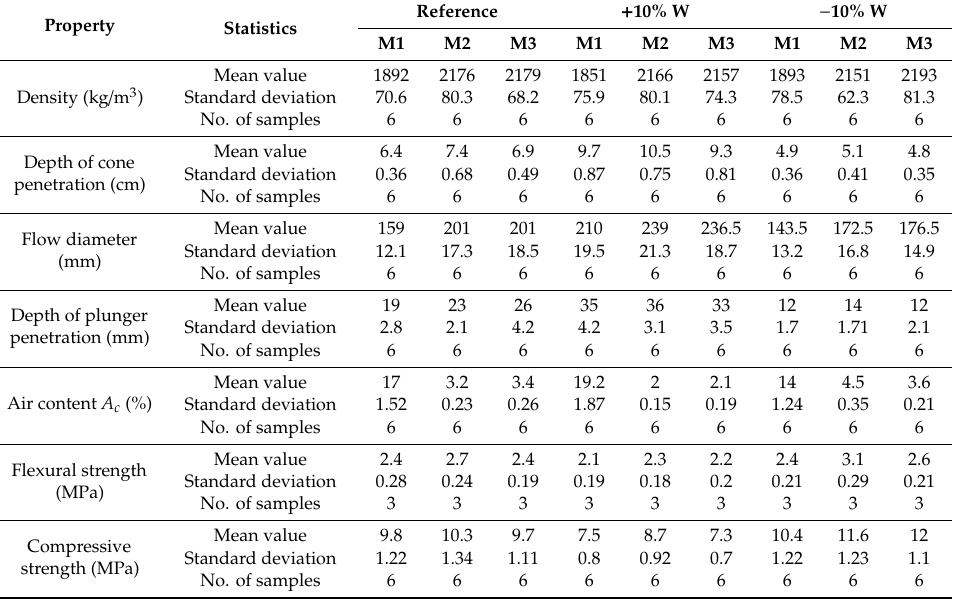
Table 14. Results of tests of the influence of water dosing mistakes on properties of masonry mortars. Property